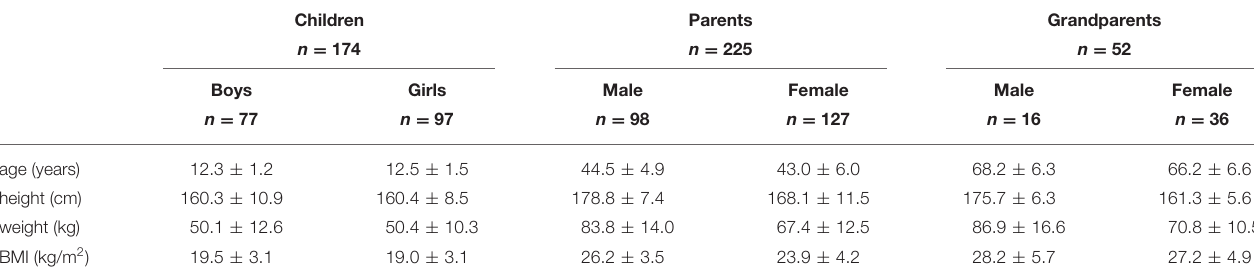
TABLE 1 | Demographic characteristics of included